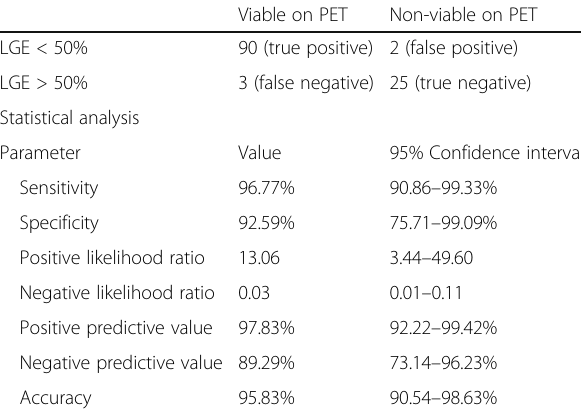
Table 2 Coronary arterial territory wise viability analysis Viable on